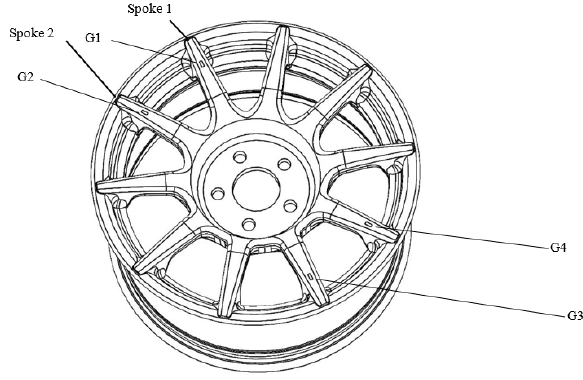
Figure 3: Placement of strain gauges on the experimental prototype